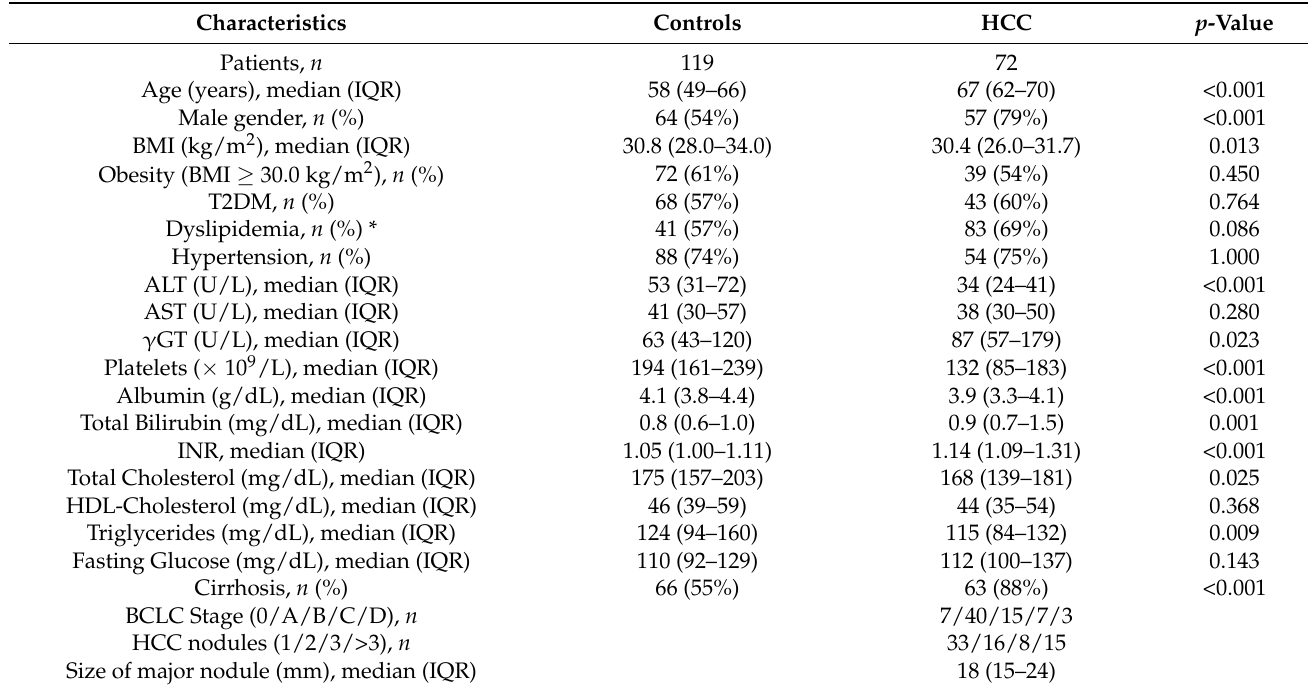
Table 1. Characteristics of the patients included in the study according to the diagnosis of